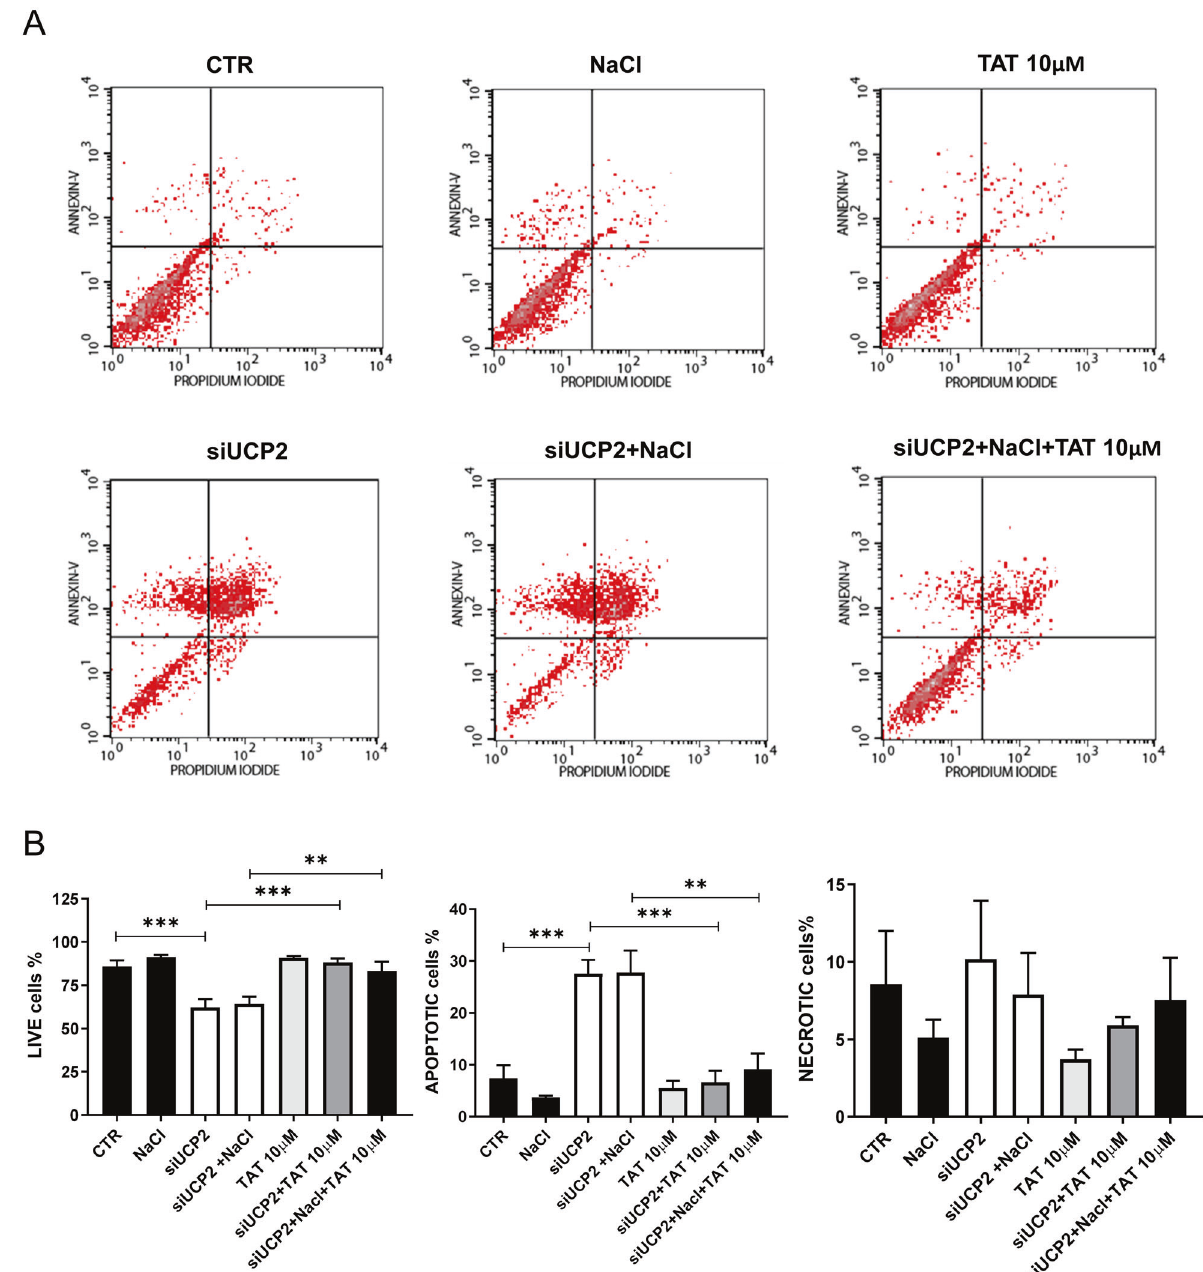
Fig. 6 Reactivation of autophagy rescues cell death in UCP2-silenced endothelial cells. FACS analysis of microvascular endothelial cells silenced for UCP2 (siUCP2) and treated for 72 h with 20 mM NaCl either in the presence or in the absence of TAT-Beclin D11 (10 μ M) ( N = 6). Representative scatter plots ( A ) and quanti fi cation of live, apoptotic, and necrotic cells ( B ) are reported. CTR indicates not transfected and not treated cells. ** p < 0.01, *** p < 0.001 obtained using the one-way ANOVA followed by Bonferroni post hoc analysis. Data are reported as mean ±